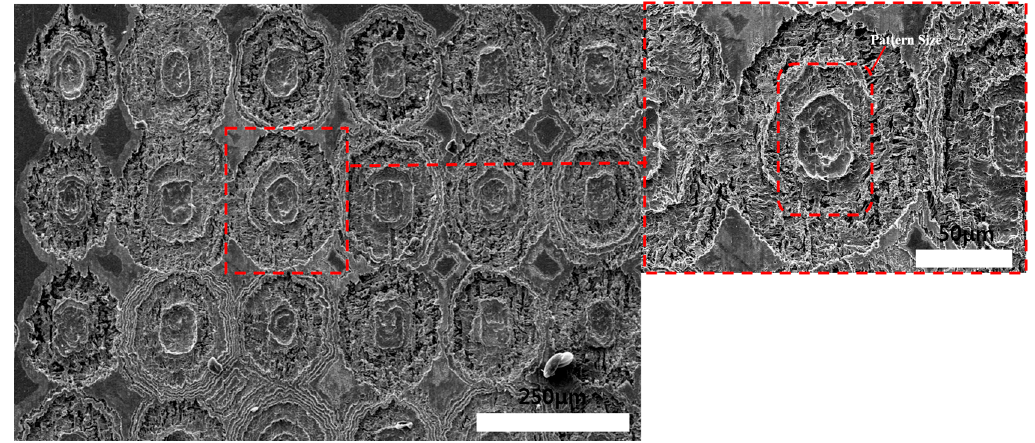
Figure 9. SEM images of Invar thin film after wet etching (photoresist coating face etching) for 15 min.